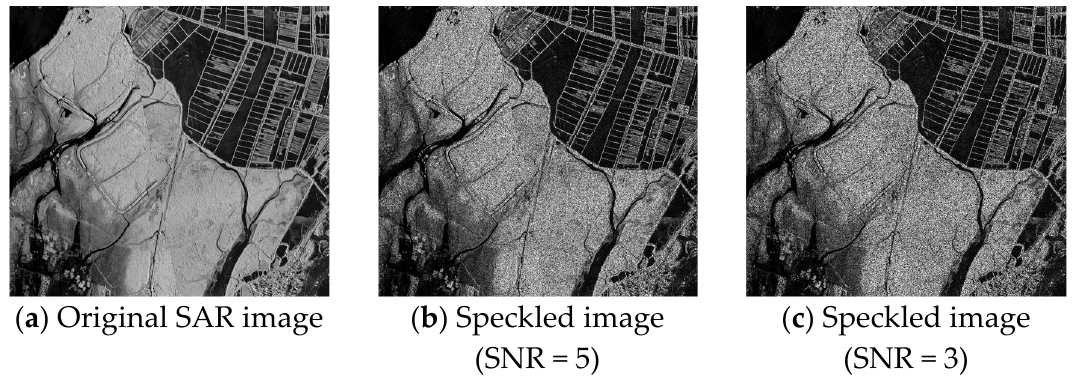
Figure 8. The speckled images with different SNR values.